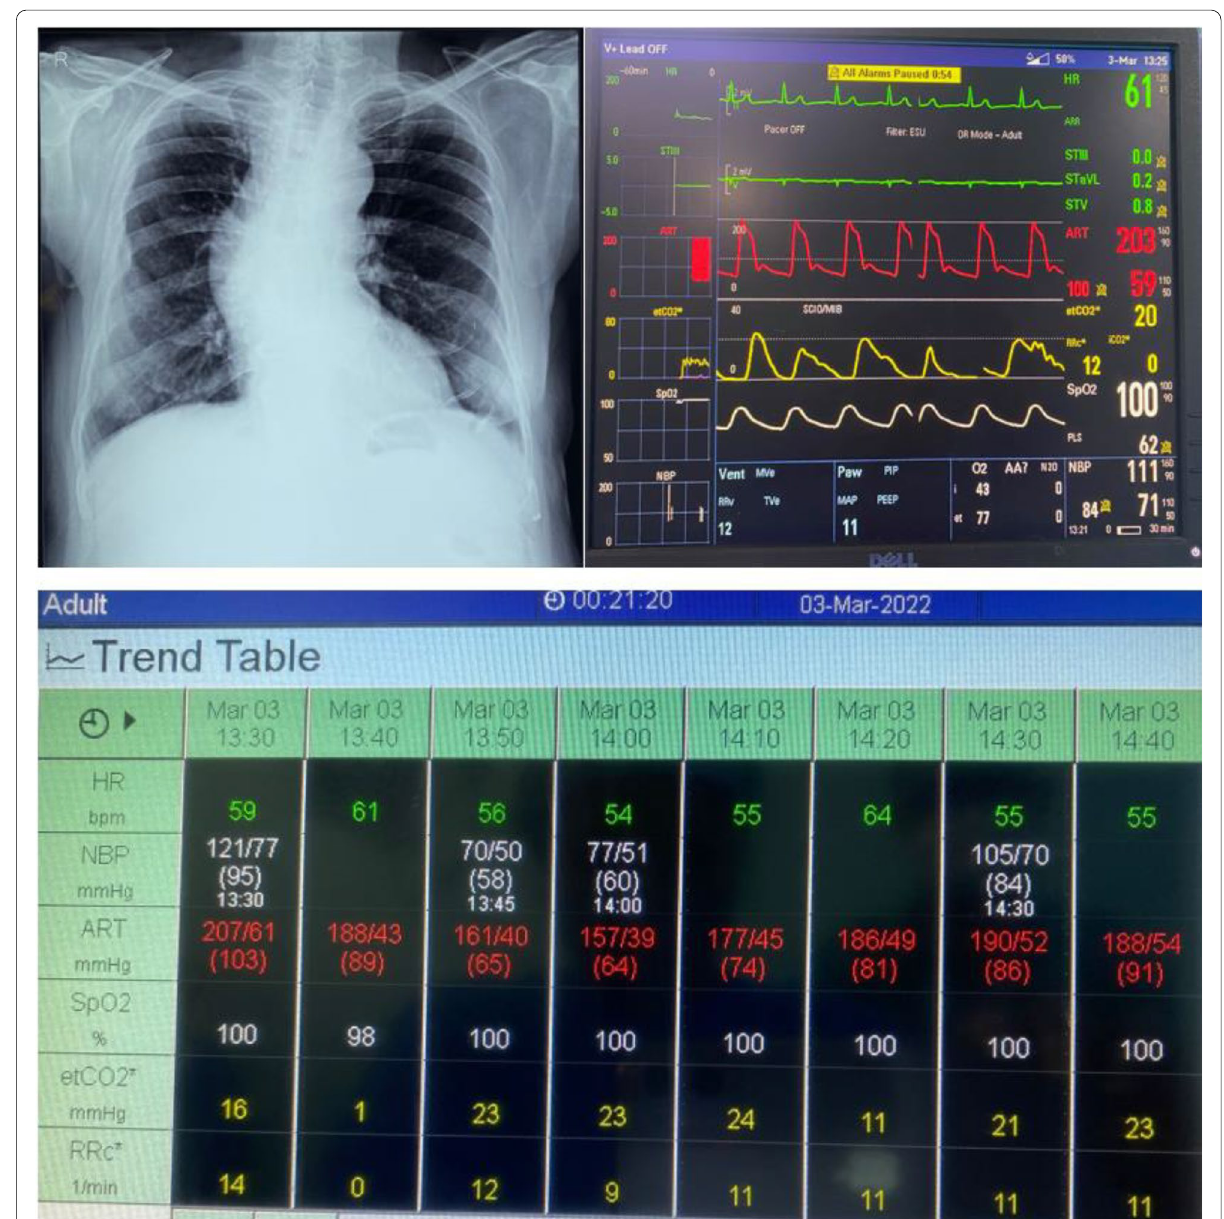
Fig. 2 Chest radiograph with dilatation of the aorta (upper left); Monitor screen showing the disparity in blood pressures between both the upper limbs (upper right); Trend table depicting the intraoperative hemodynamic changes over time (bottom